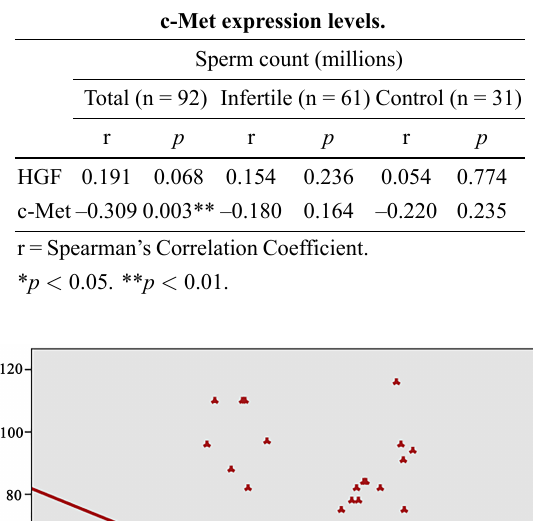
Fig. 2. Positive correlation between sperm motility percentage and c-Met expression level in the total cohort (r = 0.421, p = 0.001).